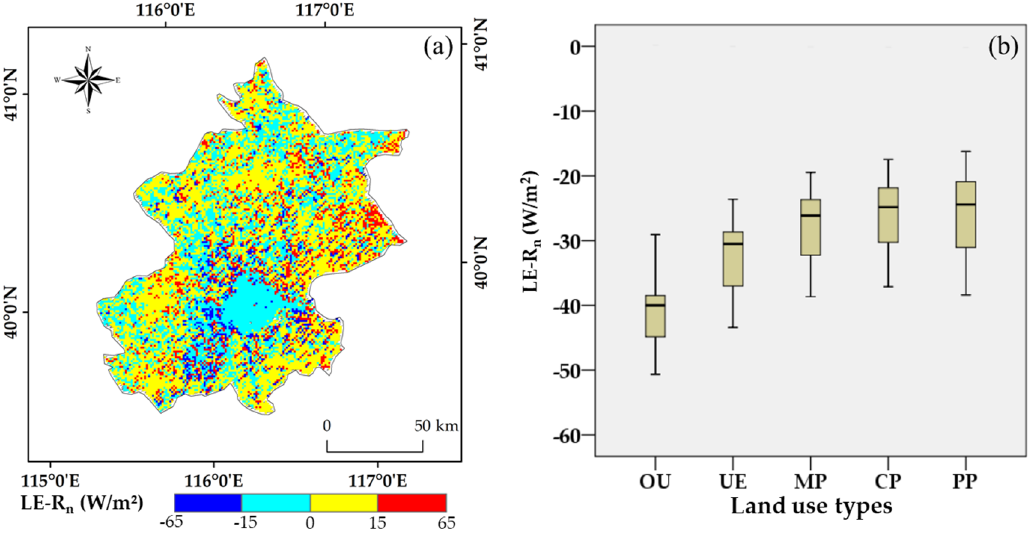
Figure 8. Di ff erence in latent heat flux and net radiation (LE − R n ) in Beijing. ( a ) Spatial di ff erence of LE − R n from 2000 to 2015; ( b ) statistical feature values of the five land use types for LE − R n from 2000 to 2015.